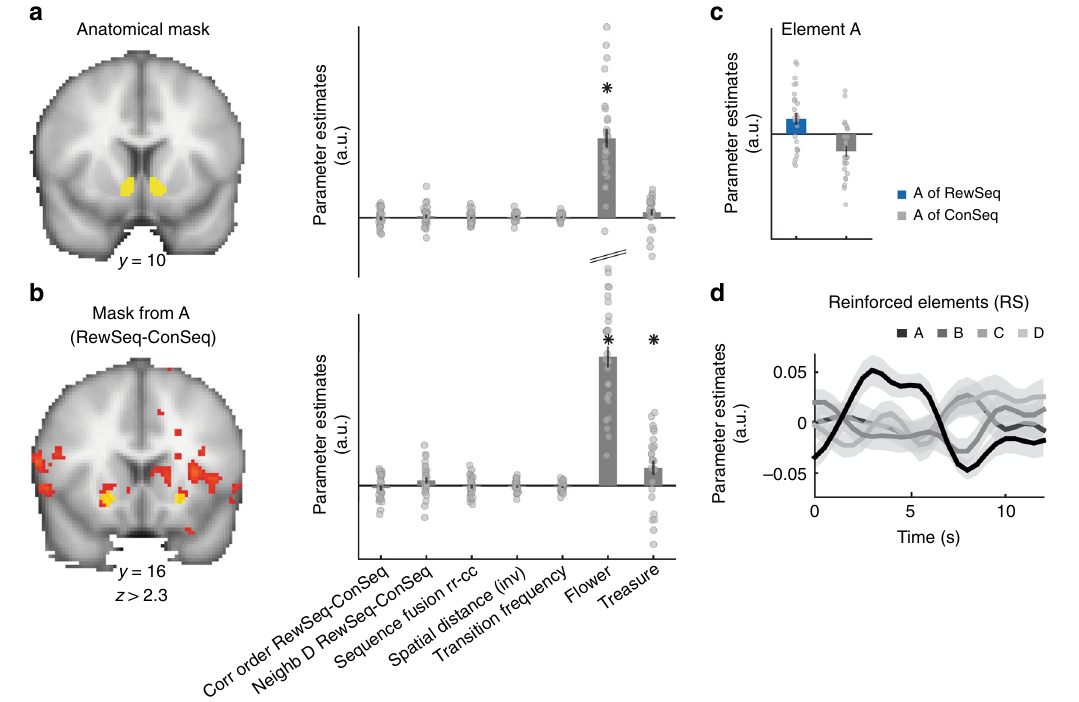
Fig. 6 Ventral striatum does not code RL- or map-like knowledge. a Anatomical mask of ventral striatum (VS) and extracted parameter estimates for all effects of interest in this study: only the BOLD response to a stimulus containing a fl ower is signi fi cant in this region. Responding fast enough (<800 ms) to a fl ower leads to monetary reward and thus the fl ower is linked to unexpected reward during scanning. b Mask of VS extracted from a contrast comparing the fi rst sequence element A between RewSeq and ConSeq. This VS region responds to both the fl ower and treasure and thus to unexpected occurrences of currently and previously reinforced stimuli. c , d Illustration of the BOLD response to element A of the sequence in the mask shown in b ; error bars denote SE; * in a , b indicates p < 0.05 in one-sample t Fig. 7; activity patterns from an adjacent hippocampal region studied by 58 are reported in Supplementary Fig. 6; BOLD activity tinguish between rewarded and control sequences). Statistical